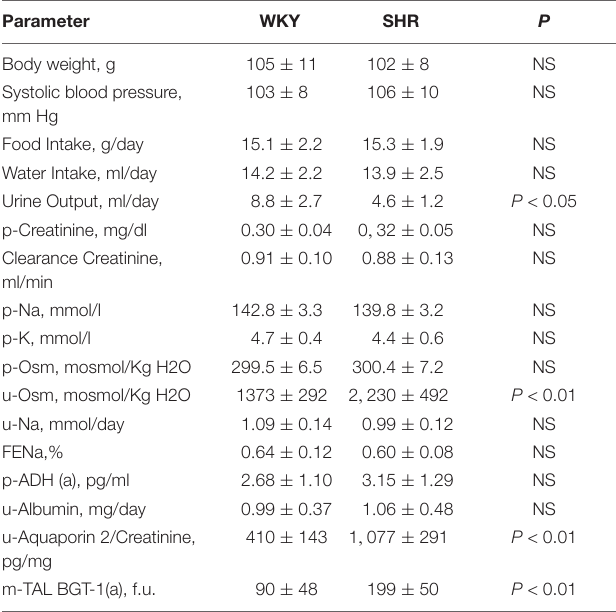
TABLE 1 | Baseline parameters of the studied groups of female (25–32 days–3–5-week-old) WKY, n = 46 and SHR, n =